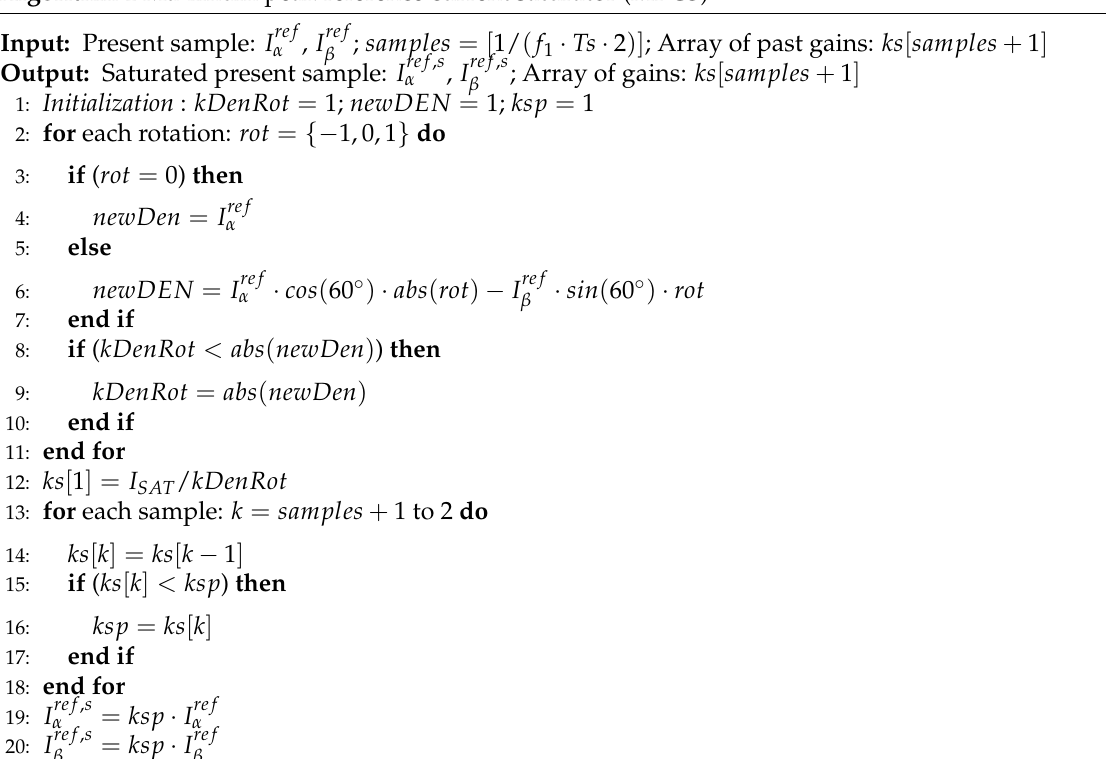
Algorithm 1 Maximum peak reference current saturator